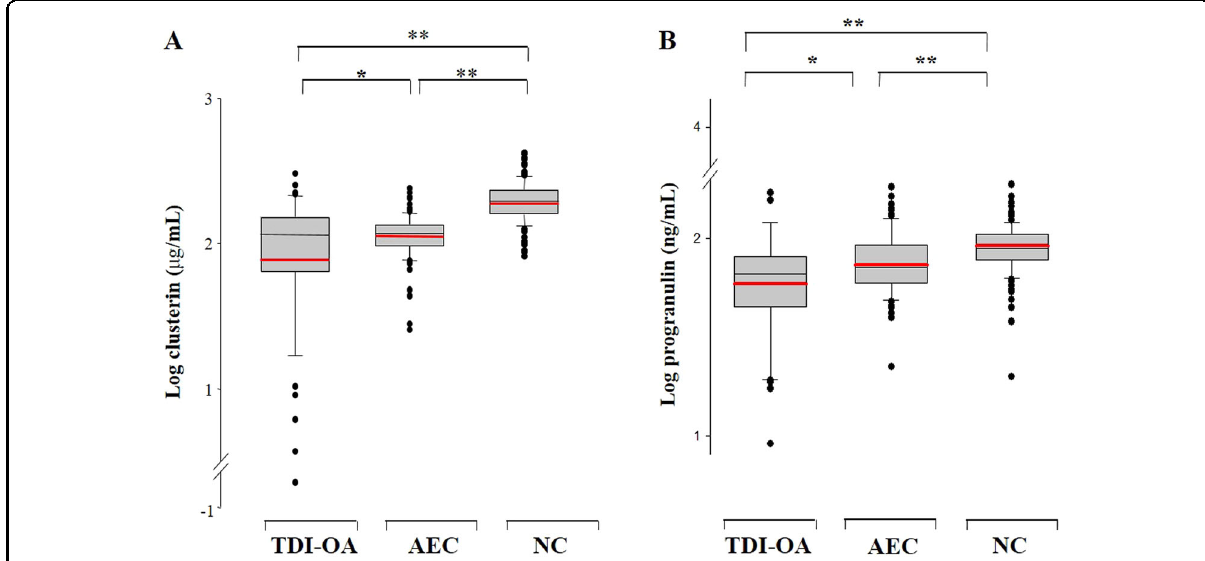
Fig. 1 Comparison of serum clusterin ( a ) and progranulin levels ( b ) in the three study groups. Statistically signi fi cant differences among the groups were assessed by ANCOVA. Box-and-whisker plots represent the 25th and 75th percentiles, with the median lines and error bars representing the 10th and 90th percentiles. The red line indicates the mean value for each group. * P < 0.05; ** P < 0.001. TDI-OA TDI-induced occupational asthma, AEC asymptomatic exposed control, NC unexposed healthy normal